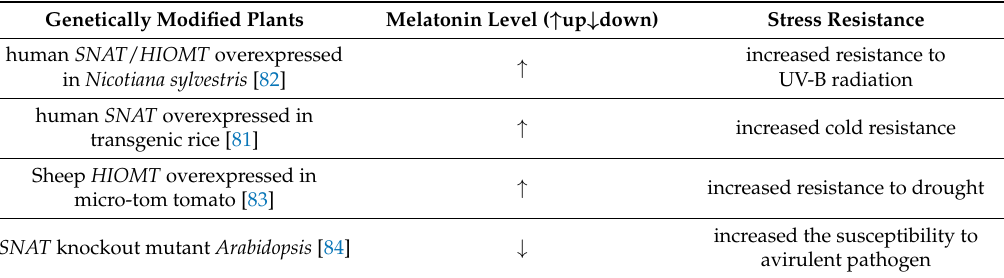
Table 2. Melatonin-related transgenic plants under